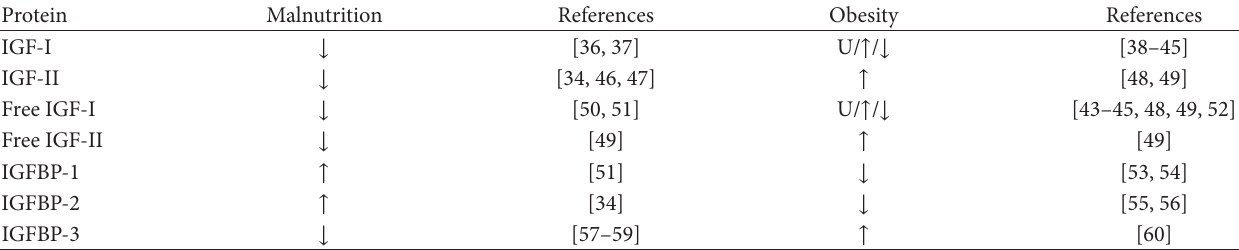
T 3: Effect of malnutrition and obesity on serum levels of proteins of the IGF axis. Protein